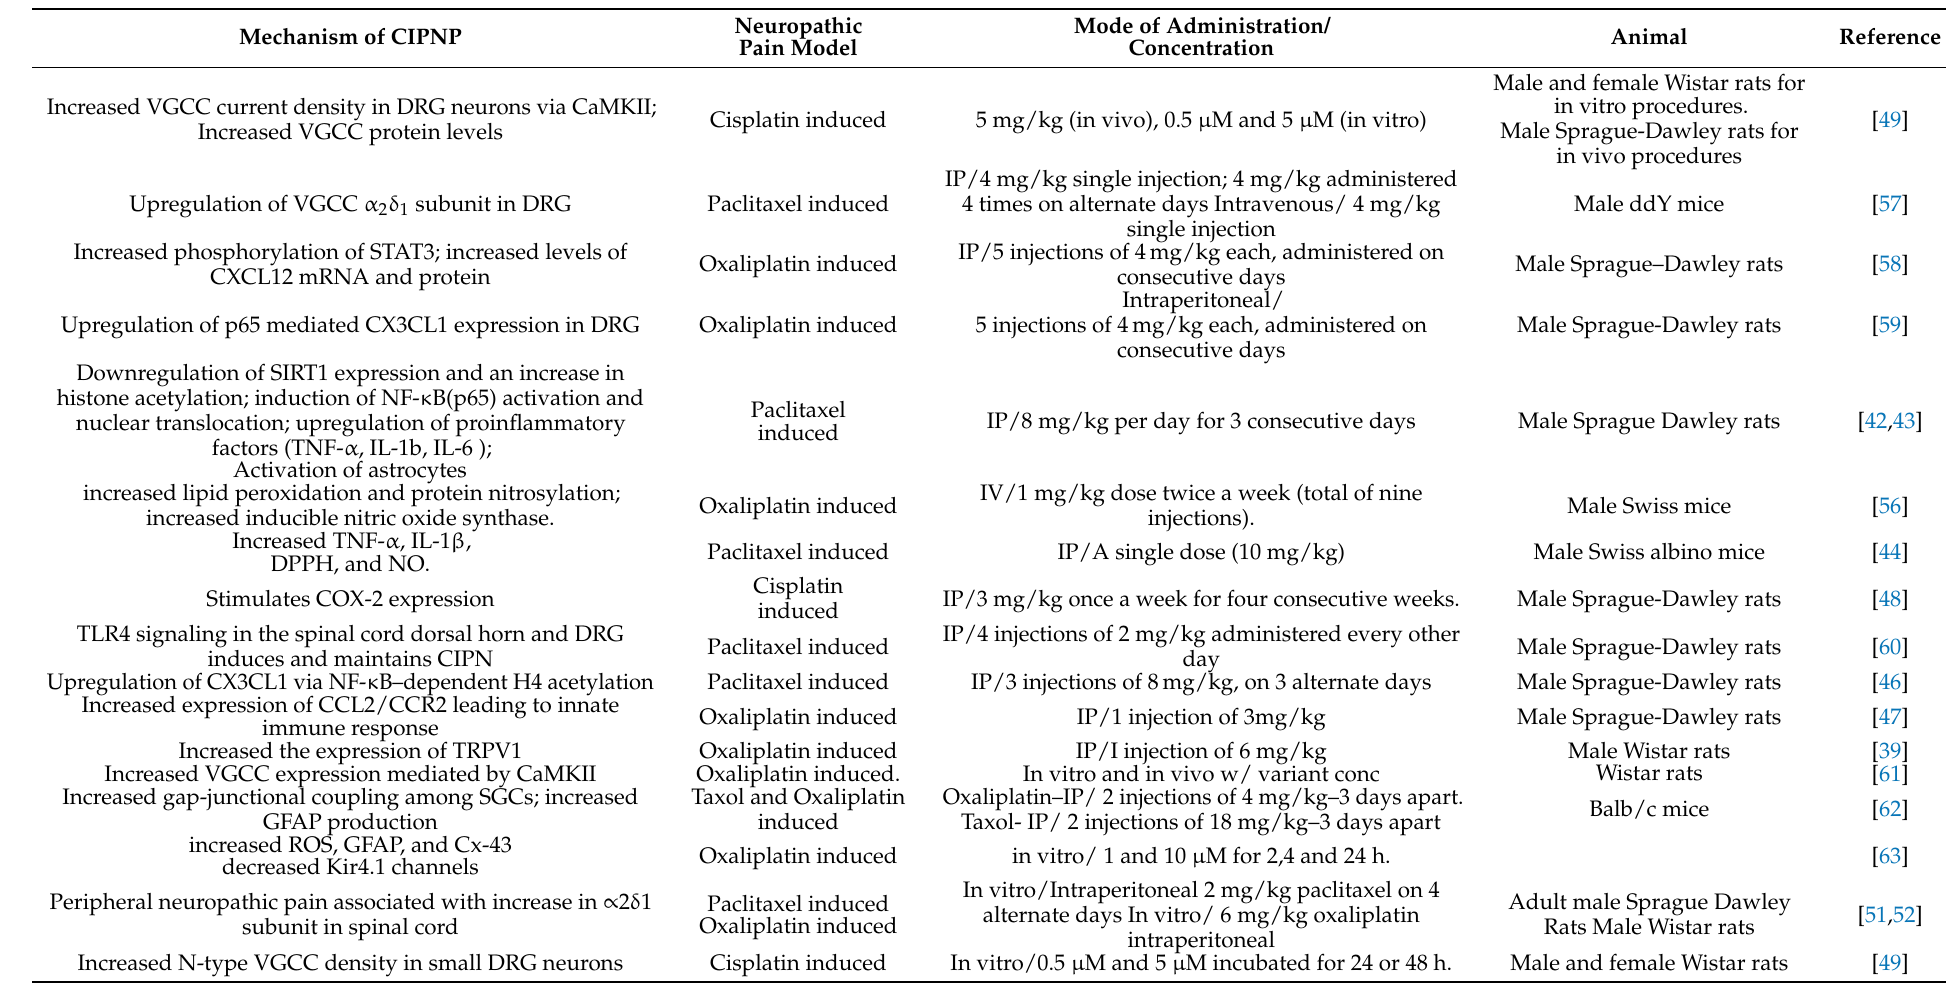
Table 3. Previous studies investigating the mechanisms by which anticancer drugs exert their effects on the